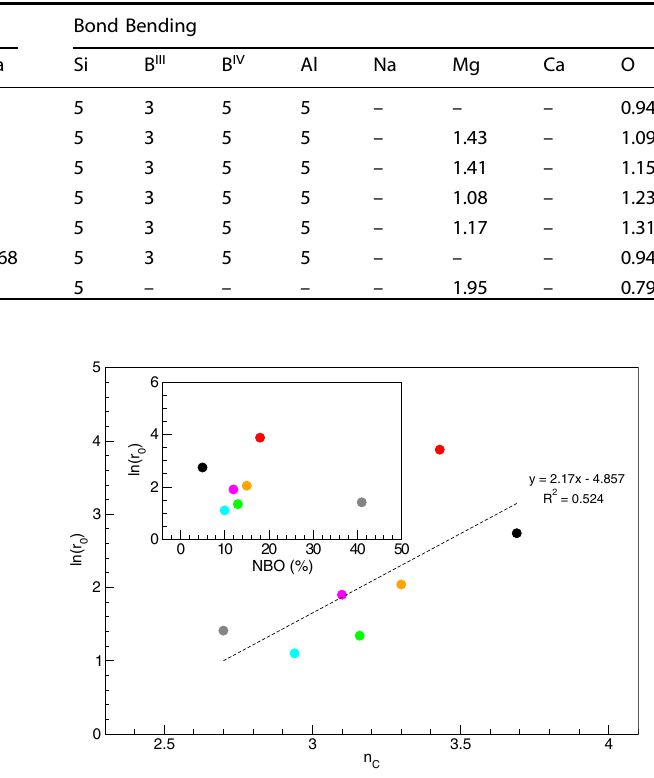
Fig. 8 Glass transition temperature for the seven simple glasses as a function of the number of constraint per atom n c , averaged on all elements. The broken line is a linear fi t to the data, the solid line is a GD 76 fi t yielding T g ( n c = 2) = 406 K and β = 0.62. The red curve is a fi t from Naumis model 77 . Colors attributed to each point corresponds to each glass as used in Fig. 1.